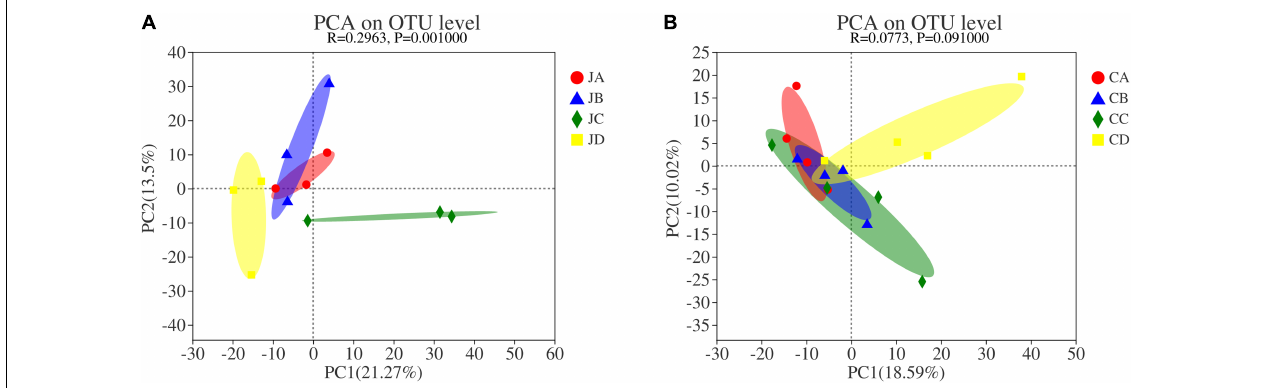
FIGURE 6 | Cluster analysis by principal coordinate analysis. (A) jejunum; (B) cecum. JA, jejunum of 0% HILM; JB, jejunum of 1% HILM; JC, jejunum of 3% HILM; JD, jejunum of 5% HILM; CA, cecum of 0% HILM; CB, cecum of 1% HILM; CC, cecum of 3% HILM; CD, cecum of 5% HILM. X- and Y-axes represent two selected main coordinate axes, and percentage represents interpretation value of main coordinate axis to difference of sample composition; scales of the X- and Y-axes are relative distances and have no practical significance; points of different colors or shapes represent samples of different groups; the closer the two sample points are, the more similar the species composition of the two